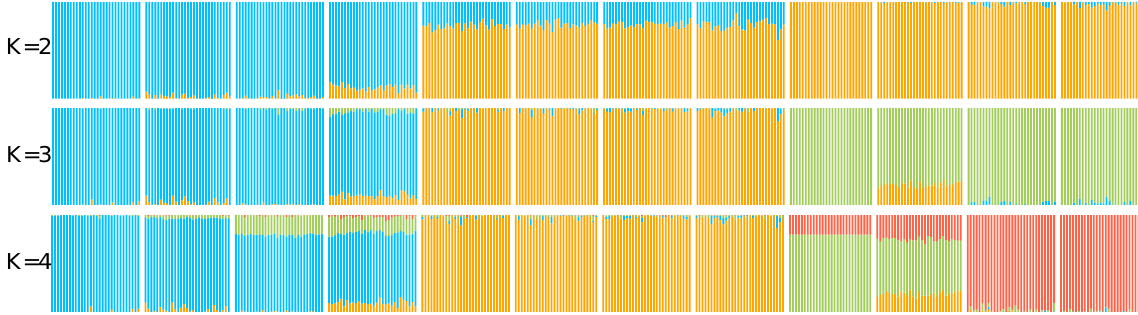
Figure 2. Results from Bayesian individual clustering with STRUCTURE for K = 2 to K = 4. For K = 2 and K = 4, all ten replicates produced the same structure. For K = 3, the major mode presented here was the result of 7/10 replicates. Minor modes are presented in Fig. S3.